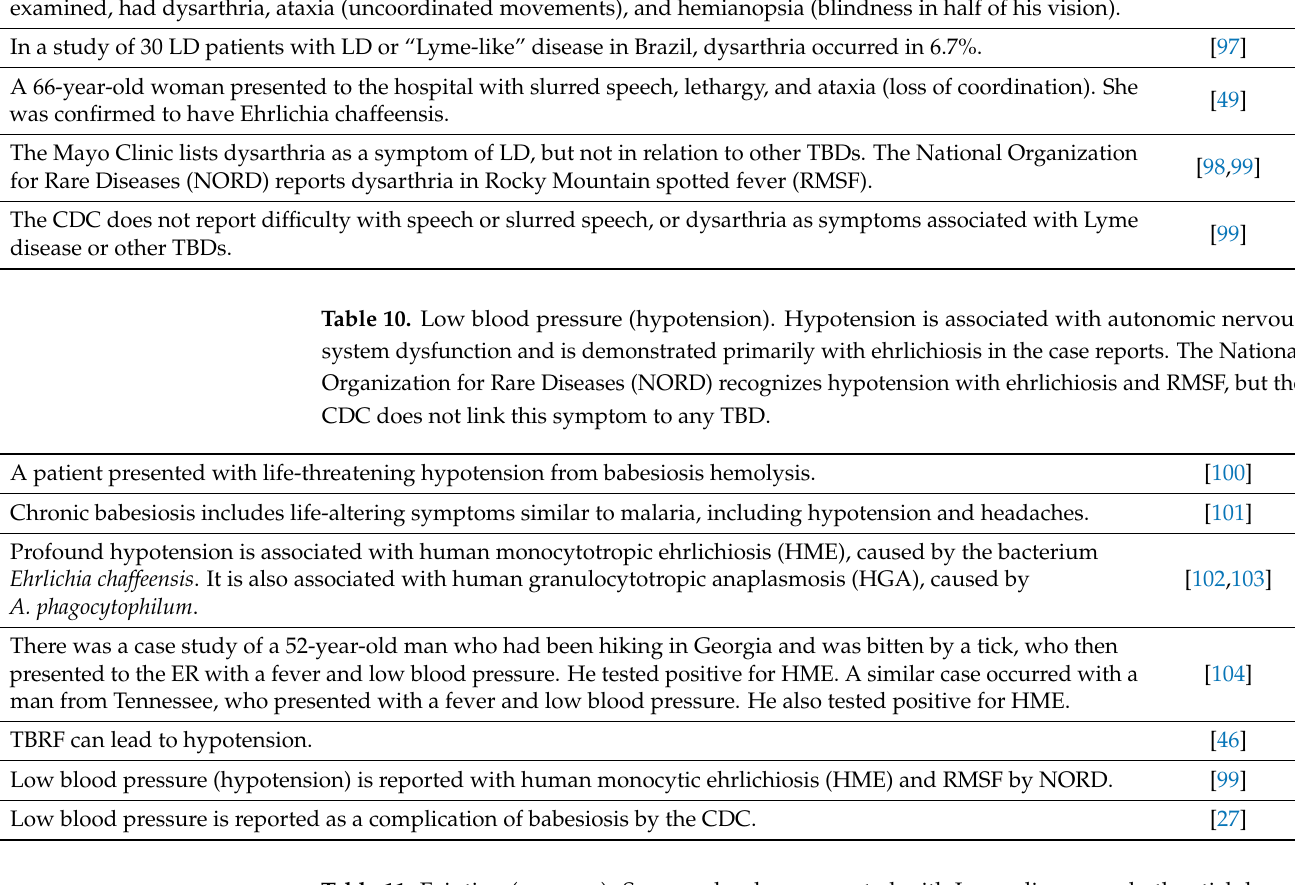
Table 11. Fainting (syncope). Syncope has been reported with Lyme disease and other tick-borne diseases. Although syncope, generally, may be associated with neurological conditions, it may have cardiovascular etiologies. In the TBD case reports, fainting tended to be associated with Lyme carditis, rather than neurological